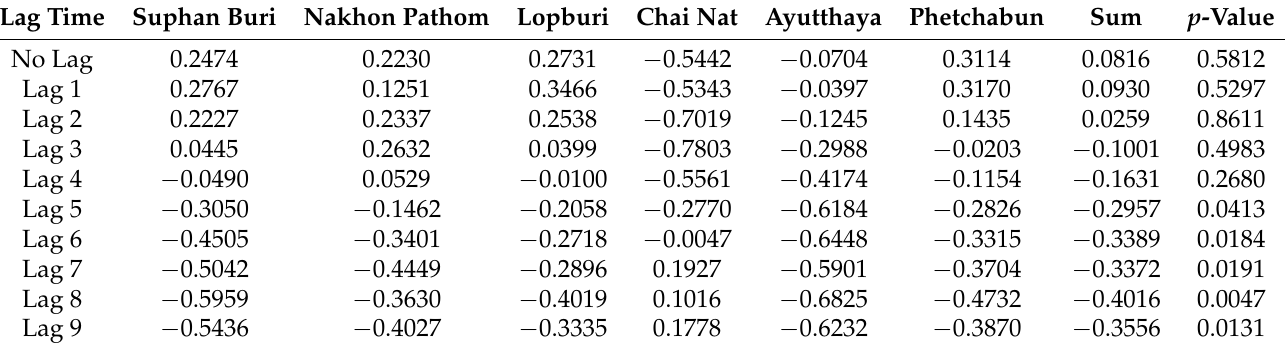
Table 3. Correlation coefficient between WOFOST and ENSO phenomena.